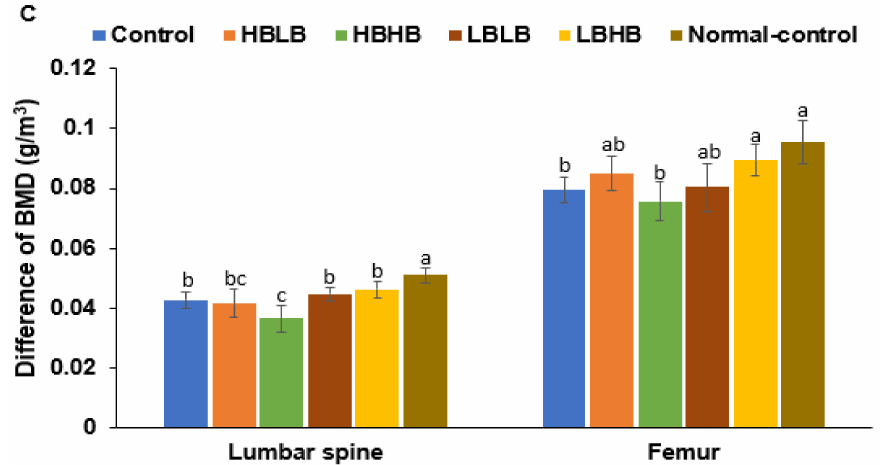
Figure 3. The differences in body composition ( A ). Differences of fat mass in abdomen and leg before and after ovariectomy. ( B ). Differences in lean body mass in the hip and leg before and after ovariectomy. ( C ). Differences in bone mineral density in the lumbar spine and femur before and after ovariectomy. Bars and error bars represent the means ± standard deviations ( n = 10). HBLB, the rats fed TMK with high contents of Bacillus spp. and high biogenic amines; HBHB, the rats fed TMK with high contents of Bacillus spp. and low biogenic amines; LBHB, the rats fed TMK with low contents of Bacillus spp. and high biogenic amines; LBLB, the rats fed TMK with low contents of Bacillus spp. and low biogenic amines. a–c Different letters on the bars indicated a significant difference among the groups by the Tukey test at p < 0.05.